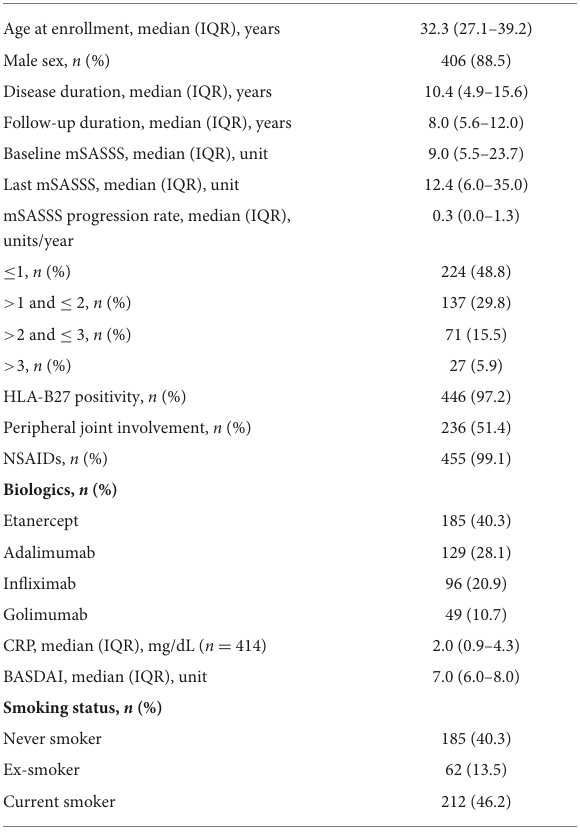
TABLE 1 Characteristics of patients with ankylosing